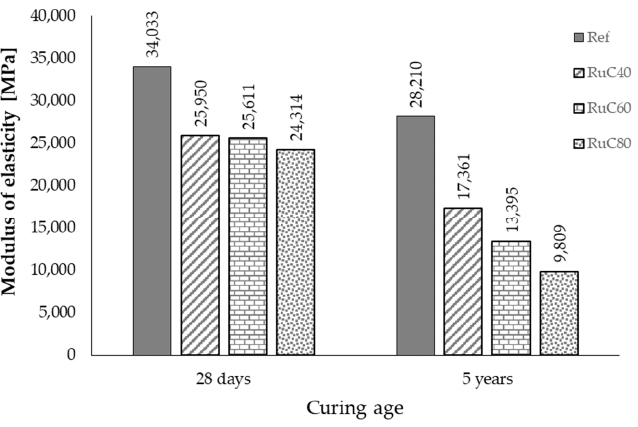
Figure 6. Variation in the static modulus of elasticity in